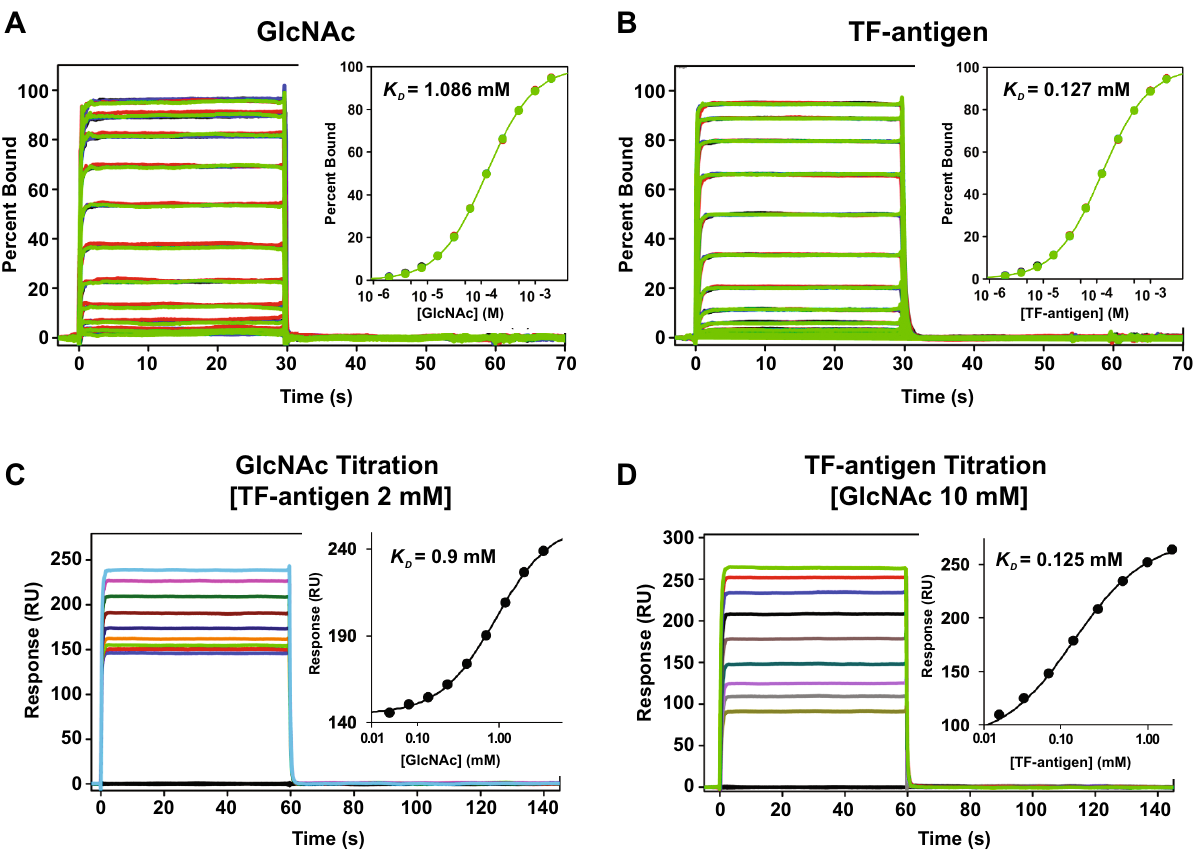
Figure 5. Ligand binding analysis of wild-type rBGL using SPR. ( A ) GlcNAc and ( B ) TF-antigen (Galβ1,3- GalNAc) were tested for binding to immobilized rBGL using a twofold concentration series up to 10 mM and 2 mM, respectively. Shown are sensorgrams captured for 8 replicate binding experiments (overlayed colored lines). Two competition binding experiments were run with the rBGL surface. ( C ) TF-antigen concentration was fixed at 2 mM while GlcNAc was tested in a twofold concentration series up to 5 mM. ( D ) GlcNAc concentration was fixed at 10 mM while TF-antigen was tested in a twofold concentration series up to 2 mM. For all experiments, equilibrium dissociation binding constants were determined by fitting data at equilibrium to a 1:1 interaction model using the software Scrubber 2. Fit curves are shown in